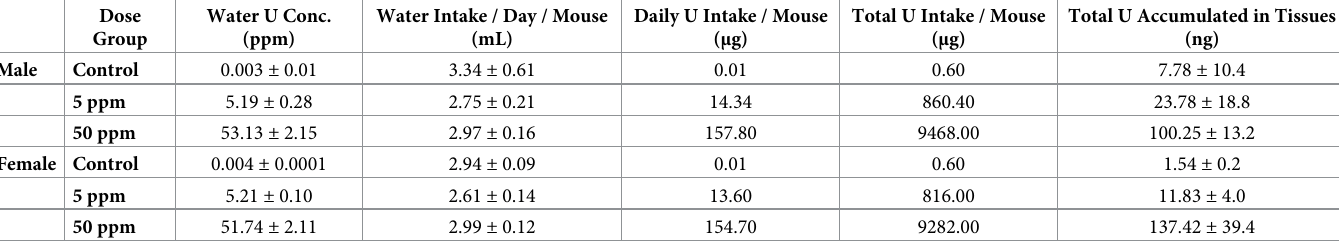
Table 1. Water concentration (based on ICP/MS results), water consumption, daily and total uranium intake, total uranium accumulated in tissues (based on ICP/ MS results) (cid:3) . n = 7/ group. mean values ± S.D. of the mean. Dose Water U Conc. Group (ppm)